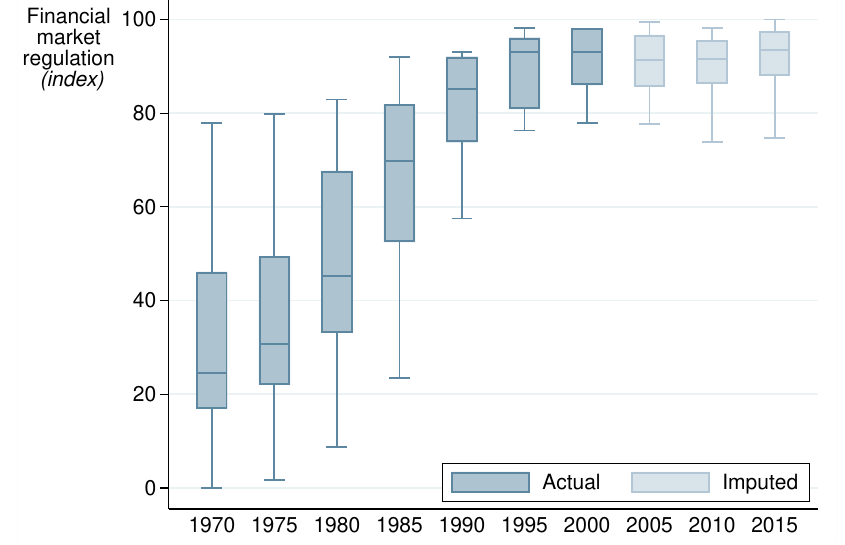
Figure 4. Financial reforms: extended indicator for OECD countries. Note: The chart displays cross-country variation of the IMF financial reform index for OECD countries between 1973 and 2018 in five-year averages. Values for years after 2005 are imputed, using the method described in (full